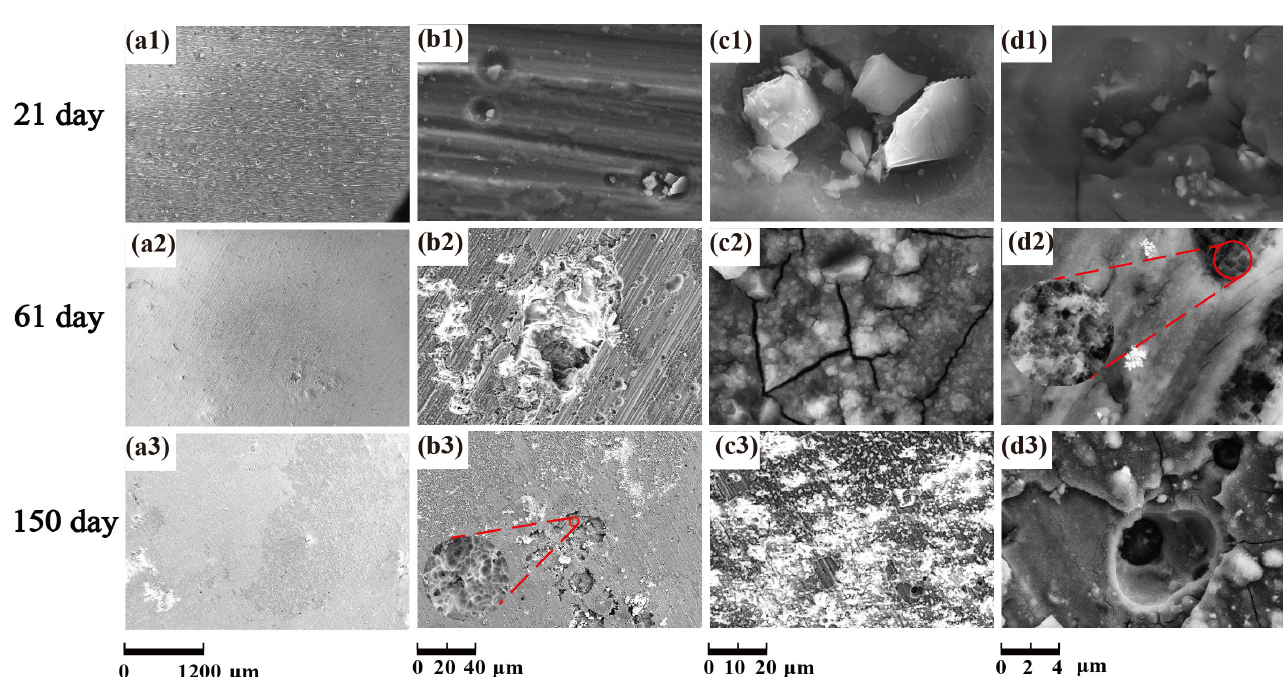
Figure 20. Corrosion product morphology of 6061Al alloy. ( a1 – a3 ) Corrosion morphology of 6061Al with low magnification; ( b1 – b3 ) Corrosion morphology of the interface of 6061Al with low magnification; ( c1 – c3 ) Corrosion morphology of 6061Al with higher magnification; ( d1 – d3 ) Corrosion morphology of 6061Al with the highest magnification.